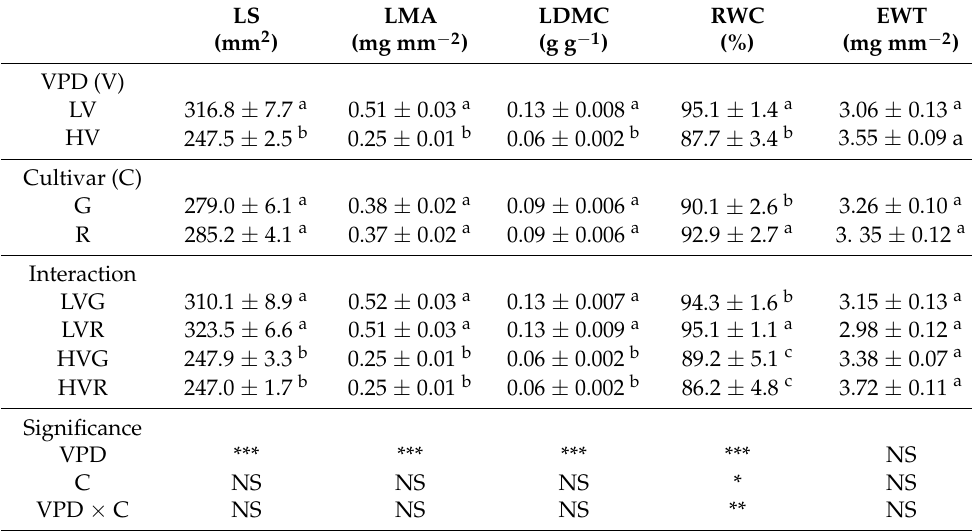
(Table S1). In general, LV plants presented more stomata and veins per leaf size with values 38 and 36% higher than HV, respectively (Figure 1a,b). Table 1. Leaf traits in terms of leaf size (LS), leaf mass per area (LMA), leaf dry matter content (LDMC), relative water content (RWC), equivalent water thickness (EWT) of green (G) and red (R) Salanova plants grown under low (LV) and high (HV) VPD, with no differences within the leaf parts. All data are reported as mean ± se (standard error). Different letters correspond to significant differences according to Tukey test ( p < 0.05).